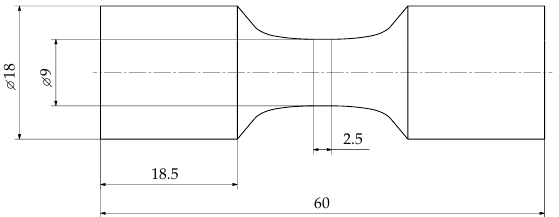
Figure 2. HCF specimen geometry A.